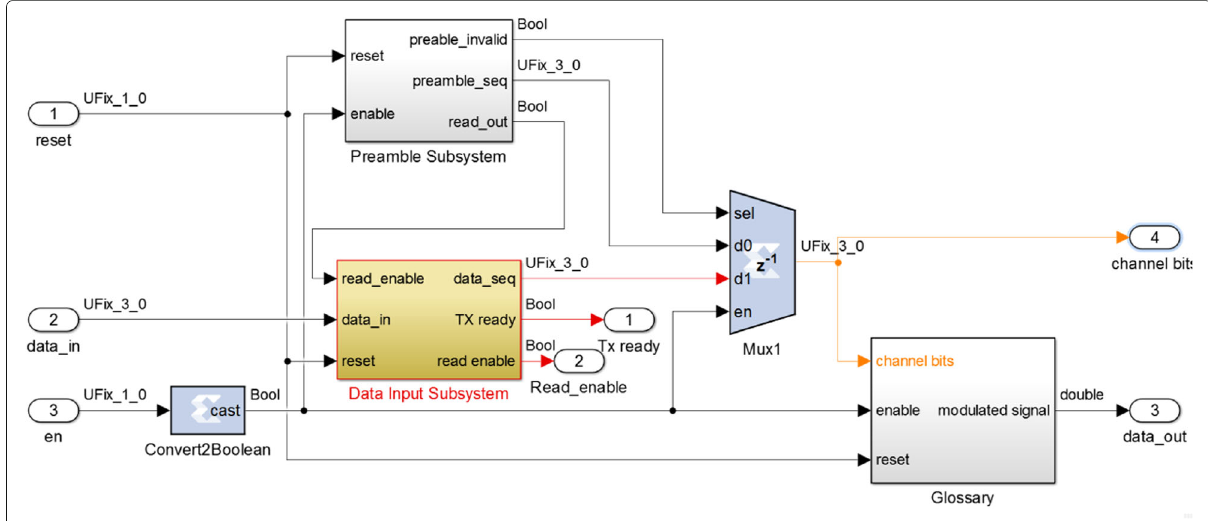
Fig. 14 The block diagram of the PBCCS transmitter